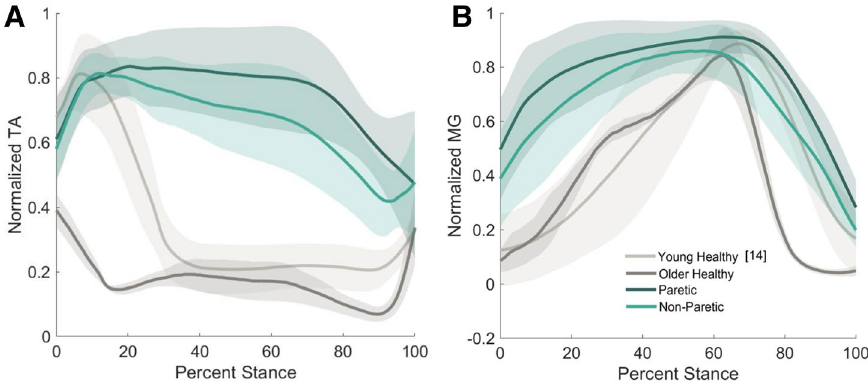
Figure 2. Average normalized EMG of the tibialus anterior ( A ) and medial gastrocnemius ( B ) across the stance phase of walking. Trials were normalized to the average peak EMG activity of a muscle throughout stance for each participant.